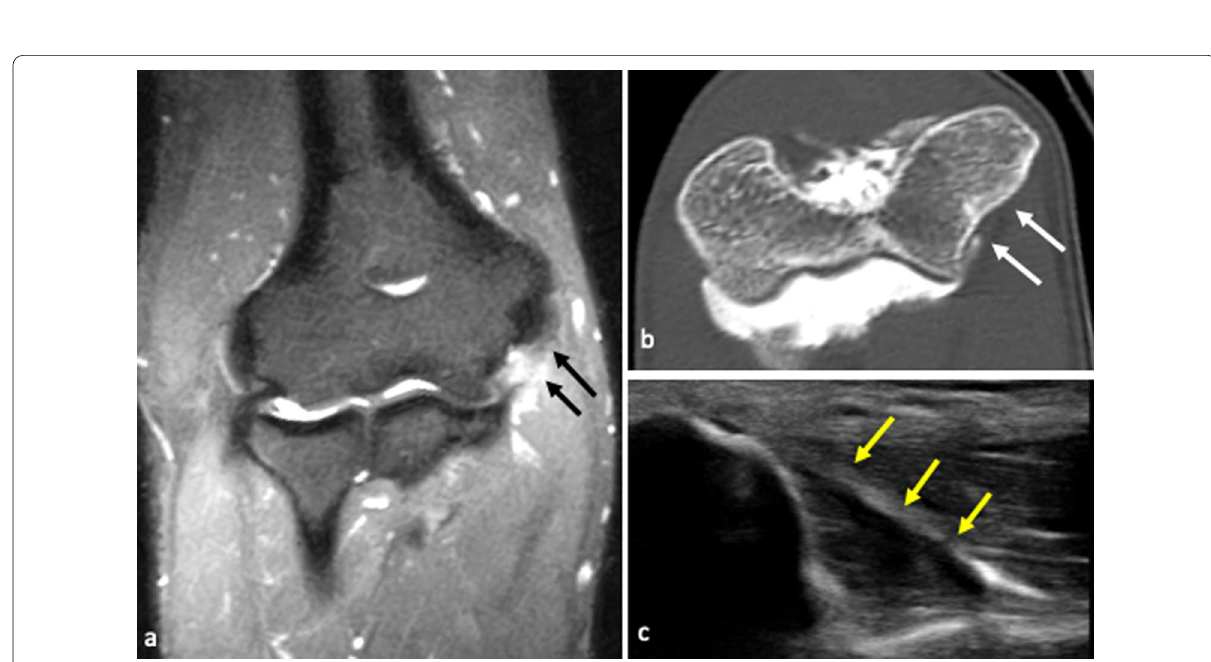
Fig. 7 Professional tennis player with chronic medial elbow pain, exacerbated during serve, not responsive to medical and physical treatments. MRI coronal fat-suppressed T2-weighted images ( a ) show a high-intensity signal at the anterior bundle (A-MCL), suggestive of partial tear (black arrows). CT-arthrography reformatted images along the major axis of the anterior bundle ( b ) demonstrate a thickened but continuous ligament (white arrows). US scan prior to contrast agent injection ( c ) confirms diagnosis by showing a thickened, hypoechoic ligament with irregular margins, although regularly inserted (yellow